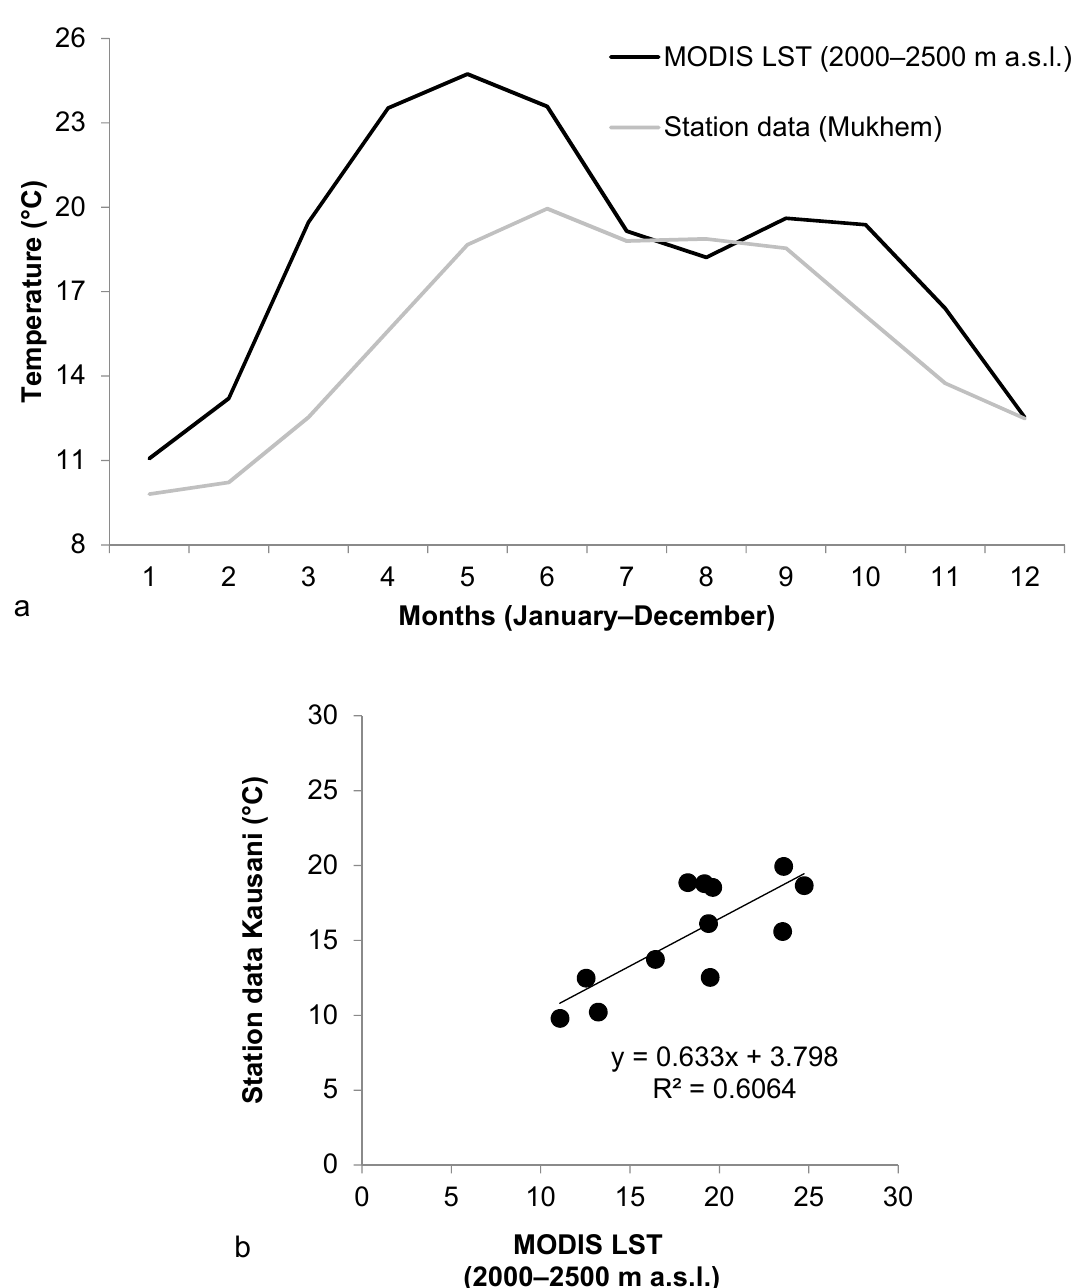
Figure 8. ( a ) Linear curve for the average value of maximum temperature for each month drawn using the temperature records at Mukhem for the years 2001–2008 and linear curve for the mean values of temperature for each month obtained using MODIS grid for the years 2001–2008 for the elevation ranging from 2000 to 2500 m a.s.l. ( b ) Scatter plot drawn using the average value of maximum temperature for each month based on temperature records at Mukhem for the years 2001–2008 and the mean values of temperature for each month obtained using MODIS grid for the years 2001–2008 for the elevation ranging from 2000 to 2500 m a.s.l.